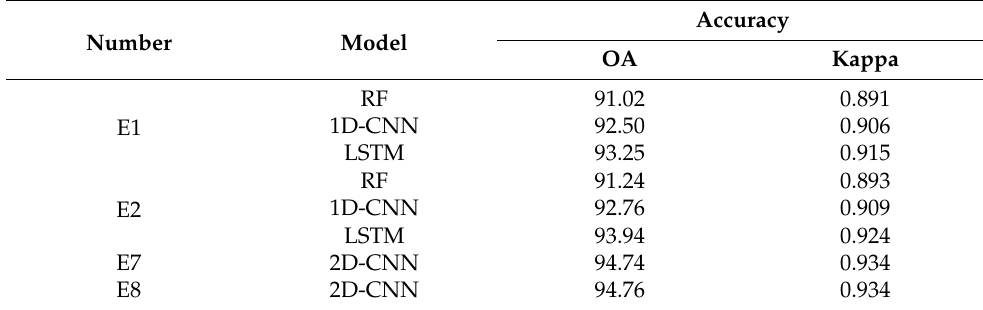
Table 5. Classification accuracy produced by various models with VI time